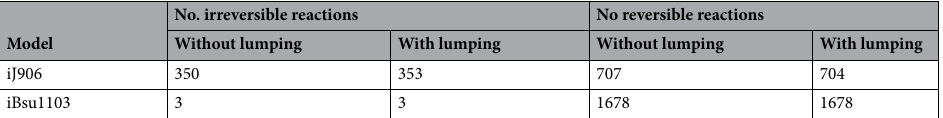
Table 3. Distribution of reversible/irreversible reactions with and without lumping. Shown are the numbers or reversible and irreversible reactions for the models iJ906 and iBsu1103 with and without lumping. A reaction is defined as irreversible if respective (cid:31) G -range is strictly negative, which is determined with a variability analysis ensuring optimal